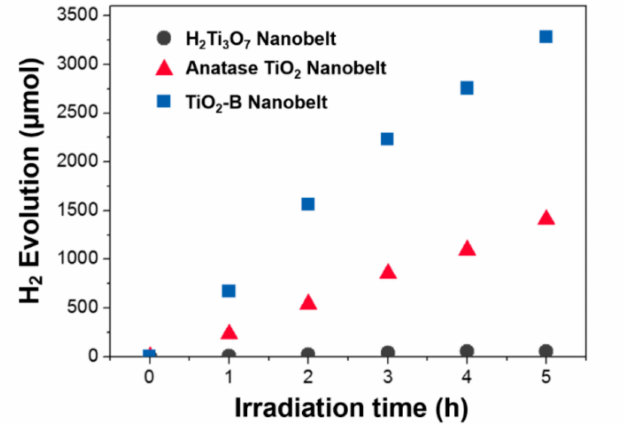
Figure 5. Comparison of photocatalytic water splitting tests of Pt-loaded (0.5%) H 2 Ti 3 O 7 , anatase TiO 2 and mesoporous TiO 2 -B nanobelts samples with the same mass (70 mg) under UV-Visible light irradiation ( λ > 300